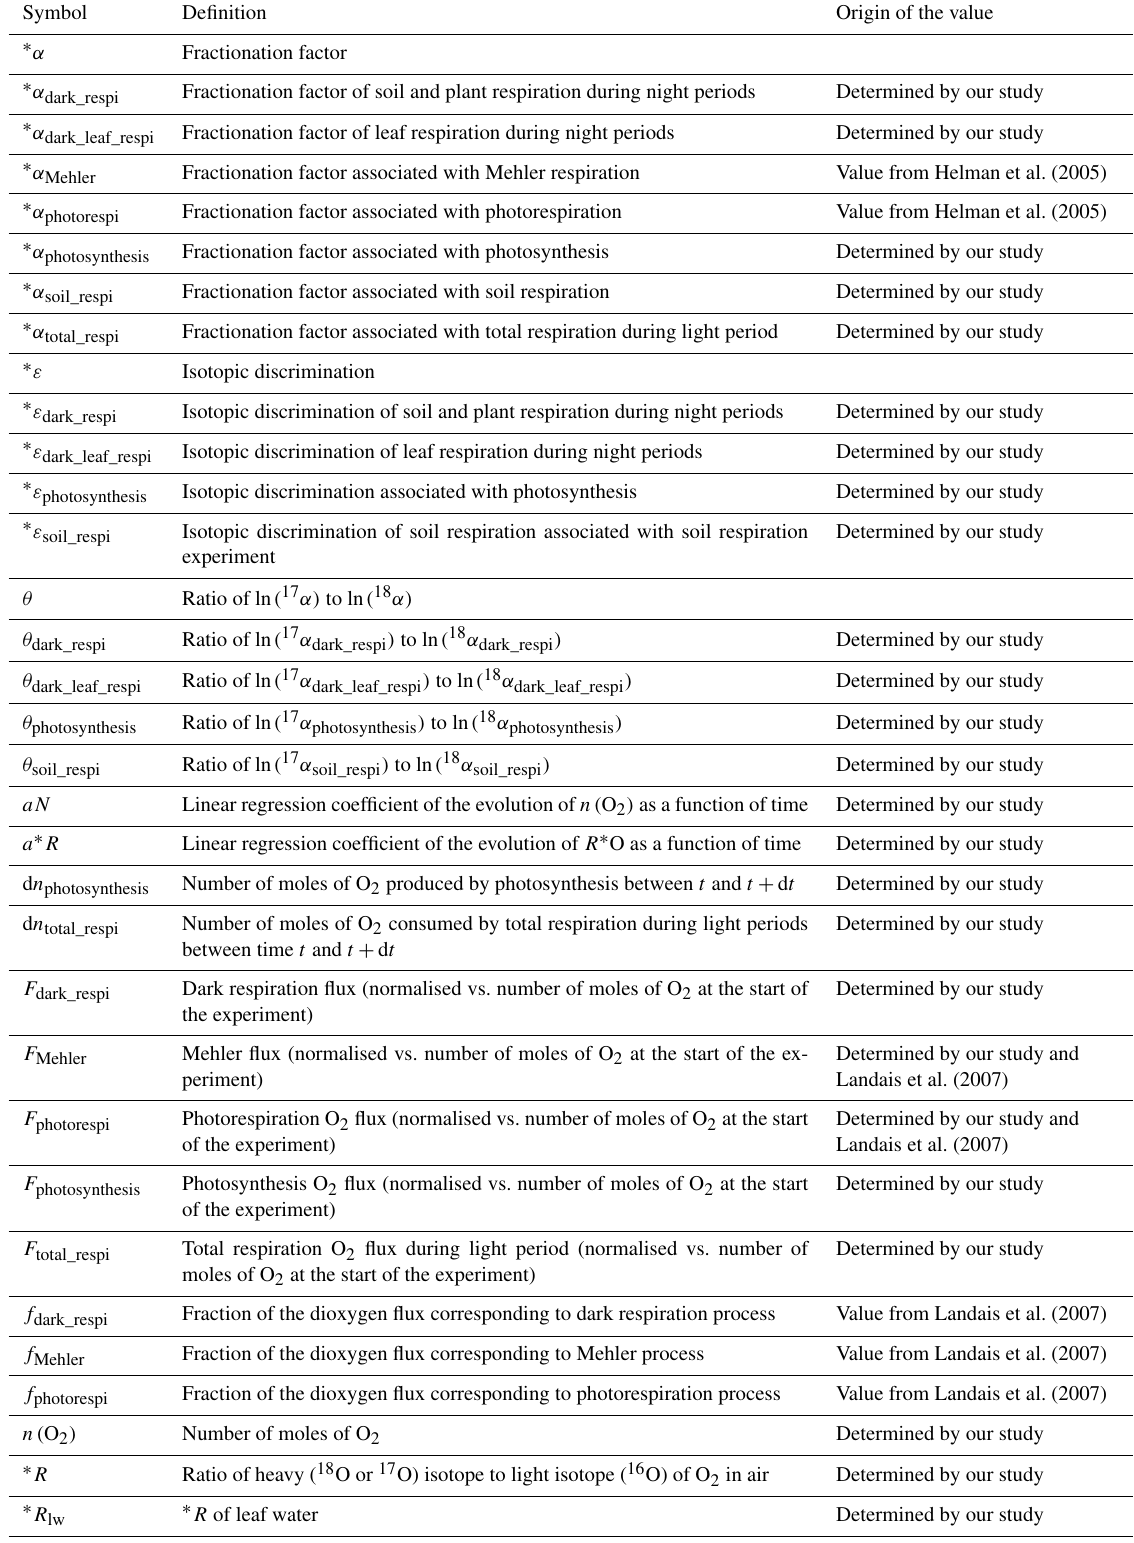
Table 1. List of variables used to quantify fractionations and their definitions ( ∗ means either oxygen 17 or oxygen 18).